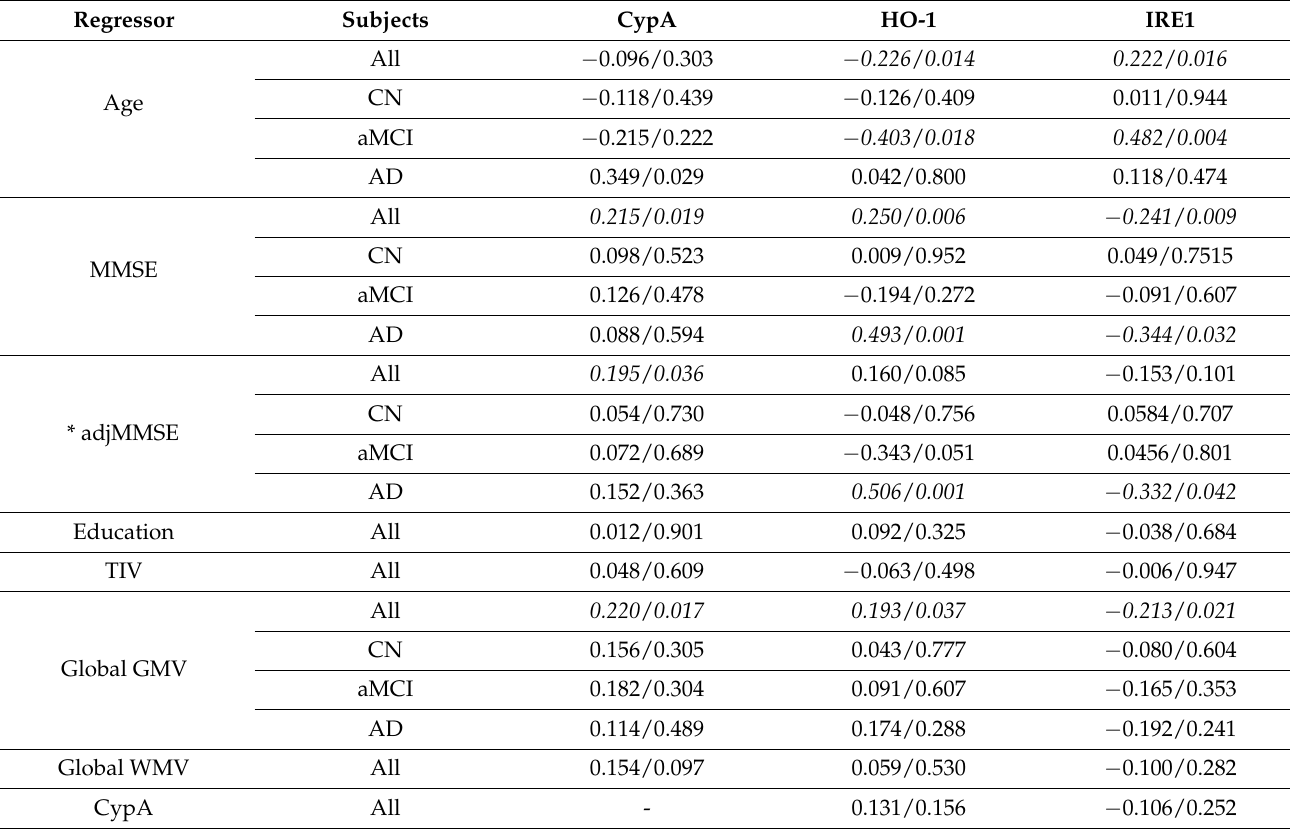
Figure 2. Correlation analyses between levels of the three blood-based biomarkers and age or MMSE score in all participants and in subgroups. MMSE, Mini-Mental State Examination Score; CypA, cyclophilin A; HO-1, heme oxygenase-1; IRE1, inositol-requiring enzyme 1; CN, cognitive normal; MCI, amnestic mild cognitive impairment; AD, Alzheimer’s disease. Table 2. Correlation analysis between levels of the three blood-based biomarkers, demographic characteristics, and global segmented brain tissue